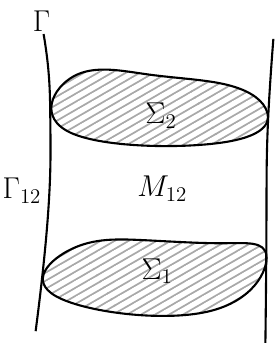
Figure 6 . We now allow Σ 1 and Σ 2 to be arbitrary surfaces anchored on Γ ; we call Γ 12 the portion of Γ delimited by ∂ Σ defines a potential (which may depend on Σ ) for Ω